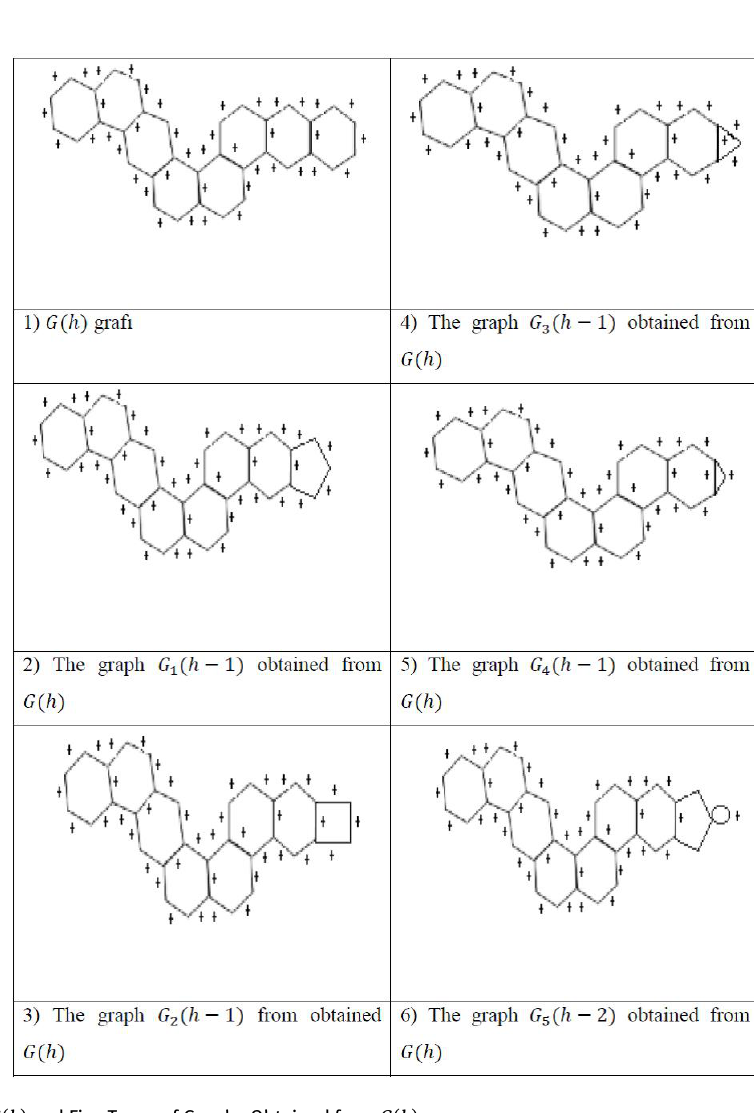
Figure 3: A Graph G ( h ) and Five Types of Graphs Obtained from G ( h